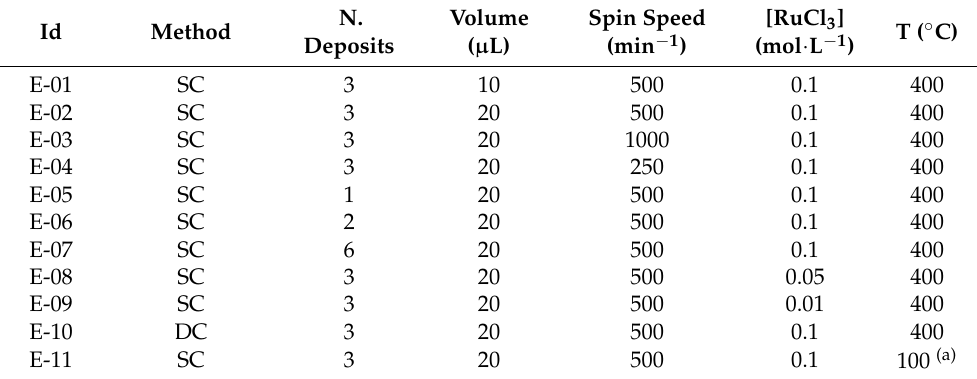
Table 1. List of fabricated